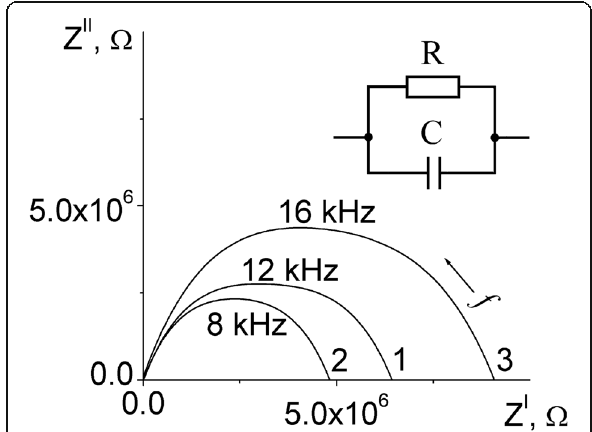
Fig. 6 Complex impedance diagrams (Nyquist plots) and equivalent circuit of multilayer system consists of perovskite organic-inorganic films prepared at the ratio of starting reagents (PbI 2 and CH 3 NH 3 І ) 1:1 (1), 1:2 (2), and 1:3 (3) on glass substrate at an illumination of 30 klx. Measurements performed at a voltage of 1 V in a dry atmosphere. The numbers above the curves are the frequency